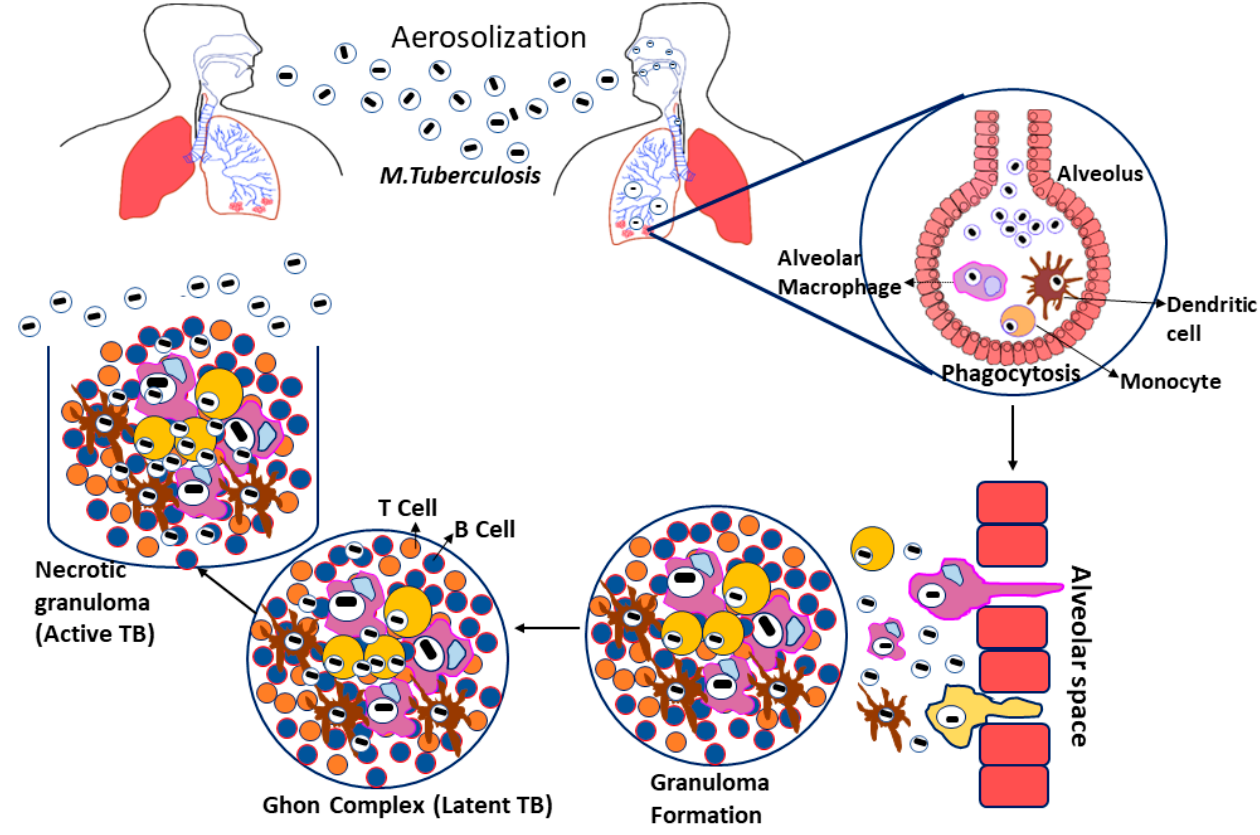
Figure 1. Pathogenesis of Mycobacterium tuberculosis .